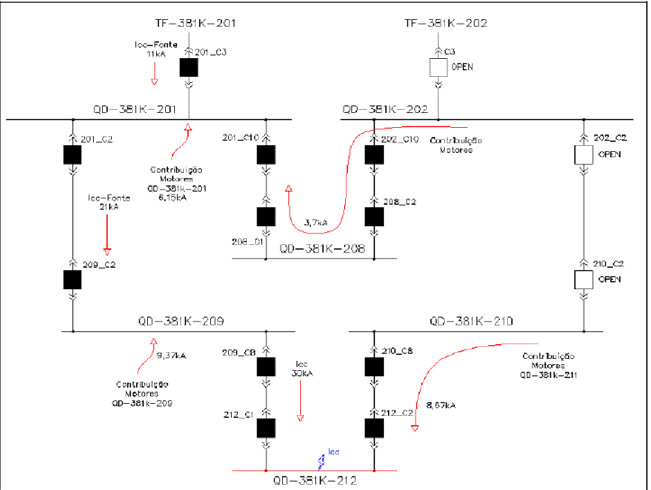
Figura 3: Esquema de seletividade convencional. Fonte: Autor,